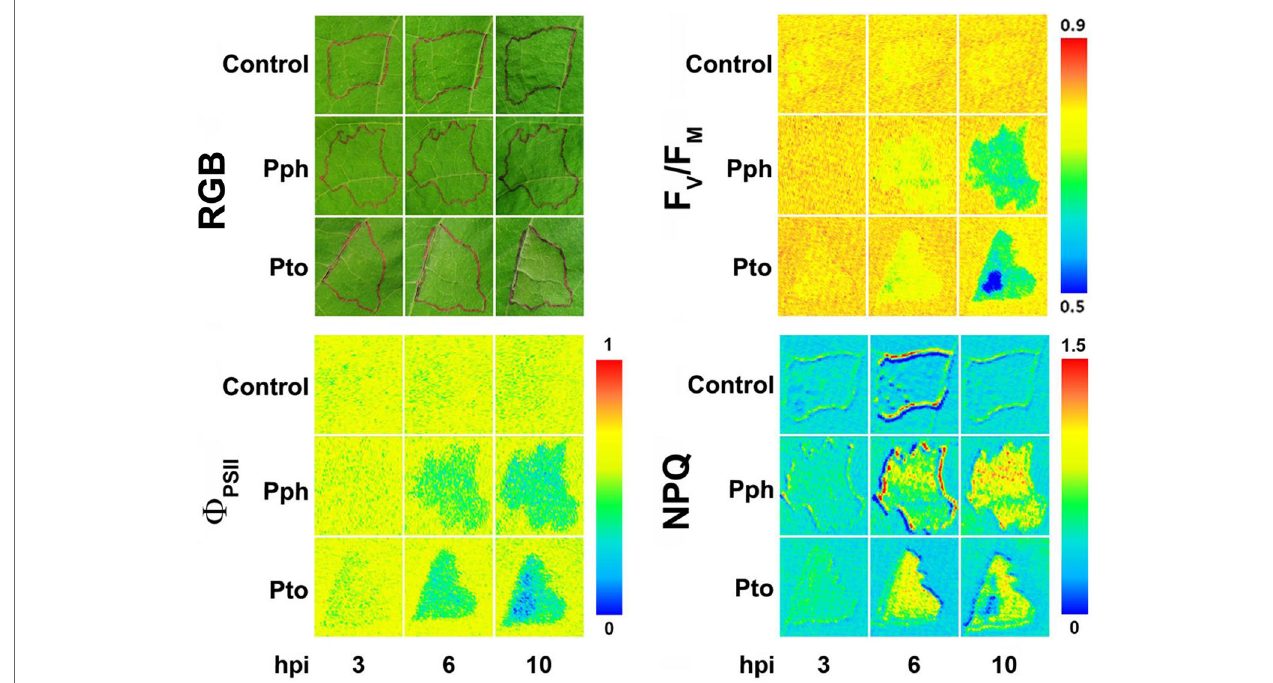
FIGURE 2 | Symptoms evolution in bean leaves infiltrated either with Pseudomonas syringae pv. phaseolicola (Pph) or pv. tomato (Pto) at high dose (10 7 cfu·ml −1 ), compared with control leaves (RGB panel). Infiltrated areas are marked in black. Representative measurements of short-term effect of bacterial infection on photosynthesis, analyzed in terms of PSII efficiency (F V /F M and Φ PSII panels) and non-photochemical quenching (NPQ panel). hpi, hours post-infection. Modified from Pérez-Bueno et al. (2015) with